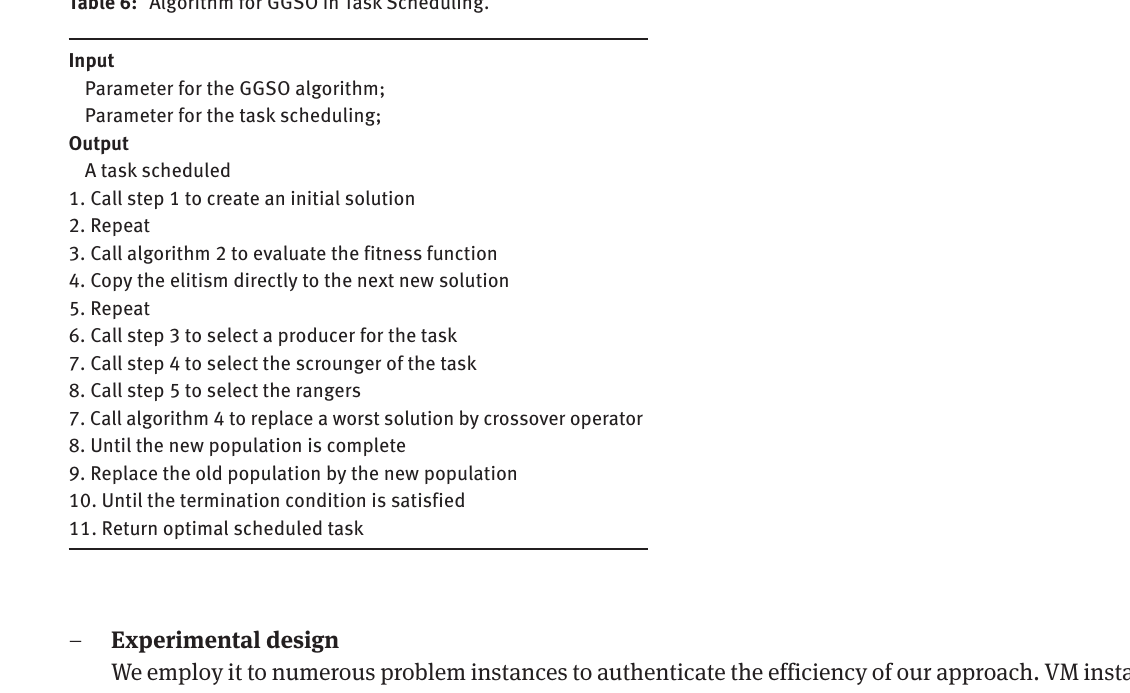
Table 6: Algorithm for GGSO in Task Scheduling.